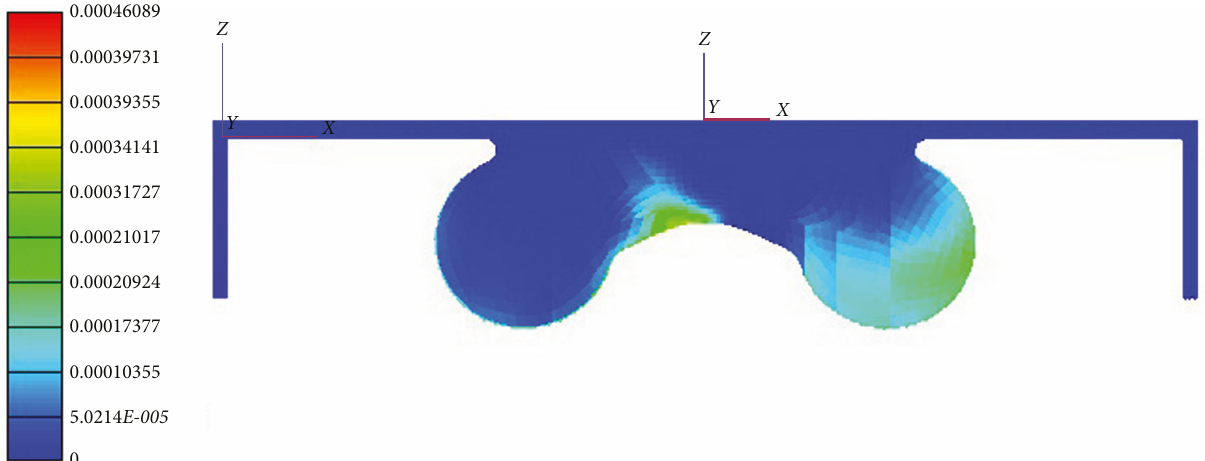
Figure 11: The distribution of soot under 730 ° CA of program 1.